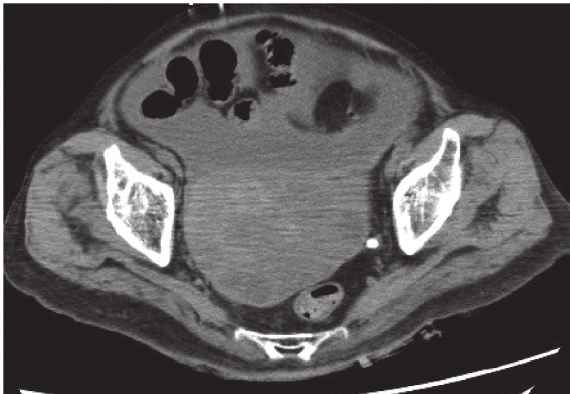
Figure 1: Plain computed tomography (CT) on admission showing ascites accumulation and fluid-containing uterine